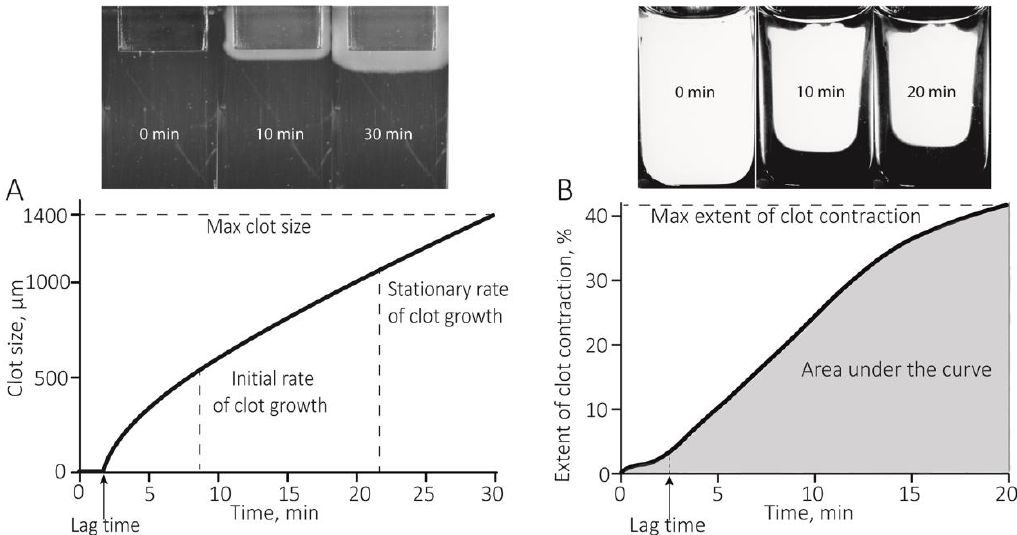
Figure 1. Results of the optical system used to quantify the spatial growth of fibrin clots (Thrombodynamics) ( А ) and the kinetics of contraction (retraction) of blood clots as a function of time ( B ). At the top are images of the cuvettes for clot growth ( A ) and clot contraction ( B ) and below are graphs of the output of these assays. For details see Materials and Methods (Sections 4.3 and